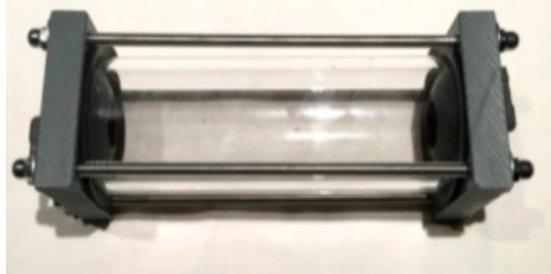
Figure A3. The bubbler.